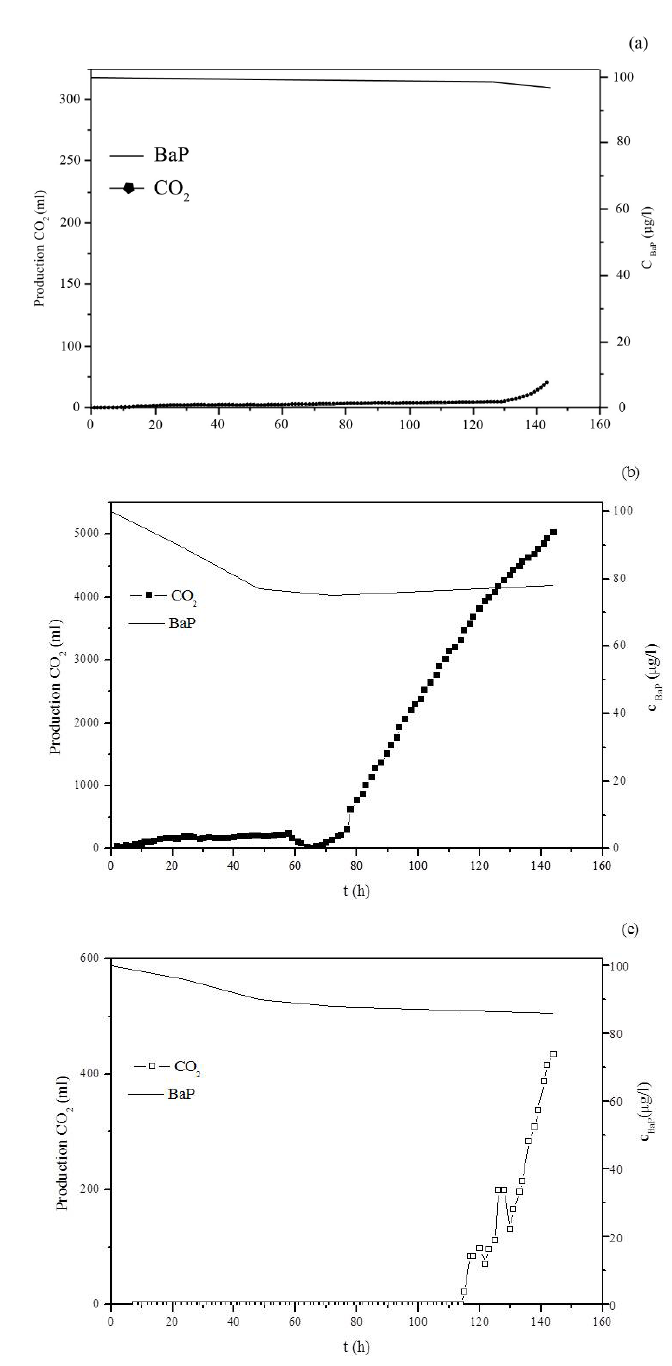
Figure 4. Production of CO and biodegradation efficiency of BaP without algae (a), live (b) or dry (c) biomass (light intensity 13.5 W m -2 2